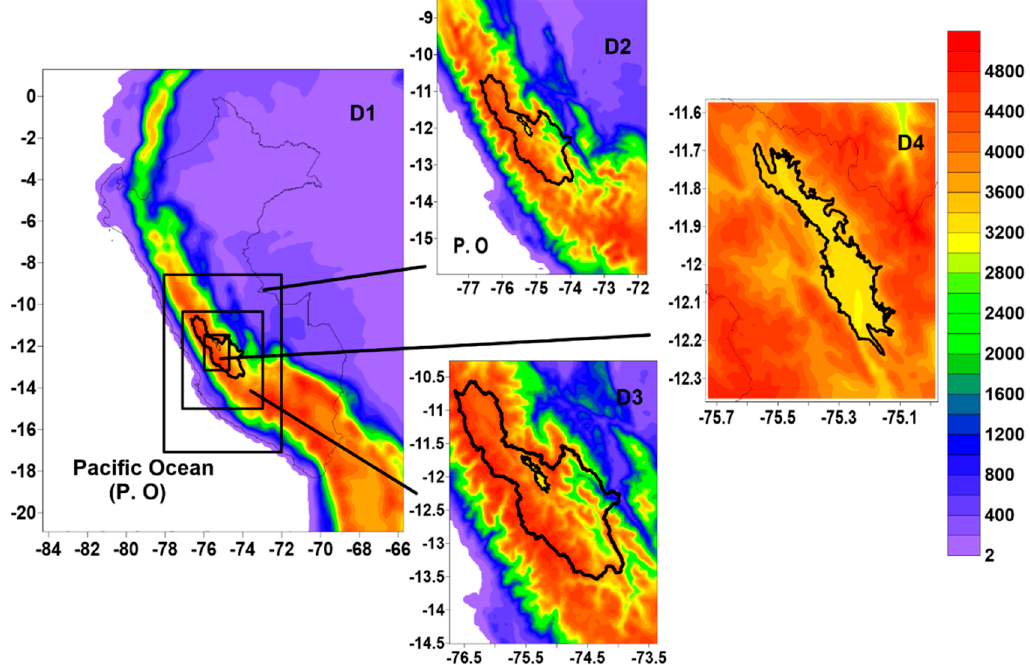
Table 2. Main characteristics of the domains and initial and boundary conditions.